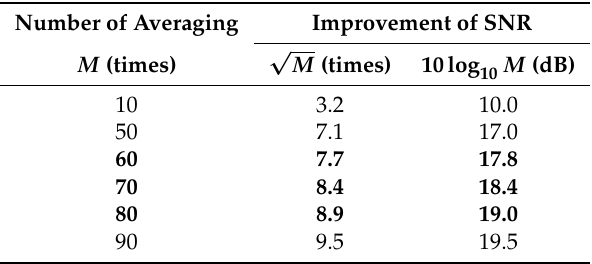
Table 1. Improvement of SN ratio by averaging